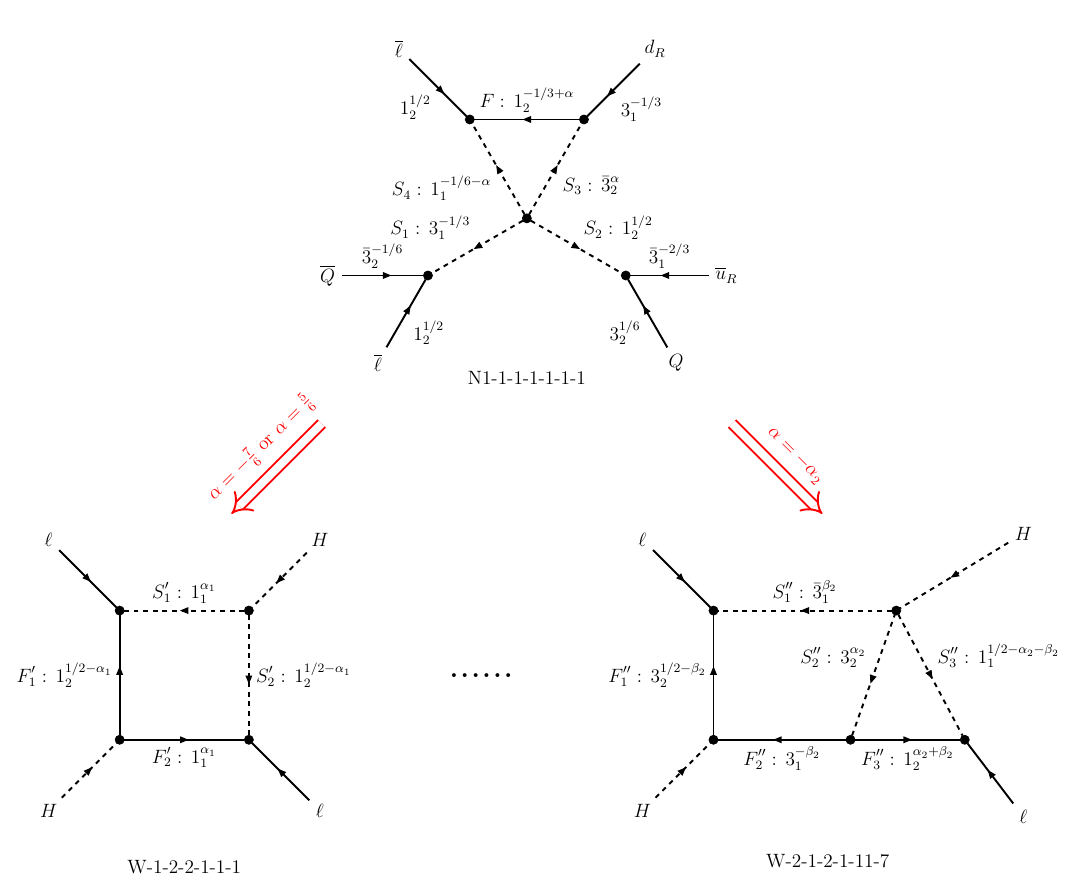
Figure 9 . The neutrino mass models generated from the 0 νββ decay model N1-1-1-1-1-1-1. The one-loop neutrino mass diagram W-1-2-2-1-1-1 can be generated by the mediators of N1-1-1-1-1-1-1 when the hypercharge α = − 7 / 6 , 5 / 6 , and the two-loop neutrino mass diagram W-2-1-2-1-11-7 can always be generated in this example. See main text for